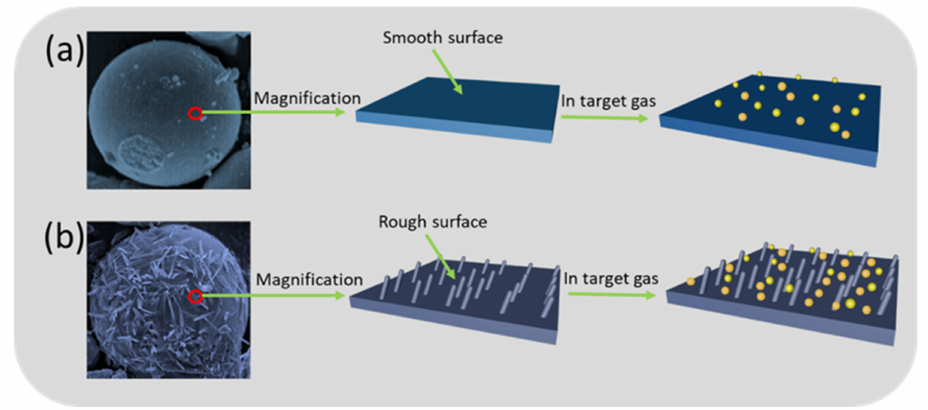
Figure 9. Schematic illustrations of the sensing mechanism. ( a ) The sensing mechanism of smooth surface. ( b ) The sensing mechanism of rough